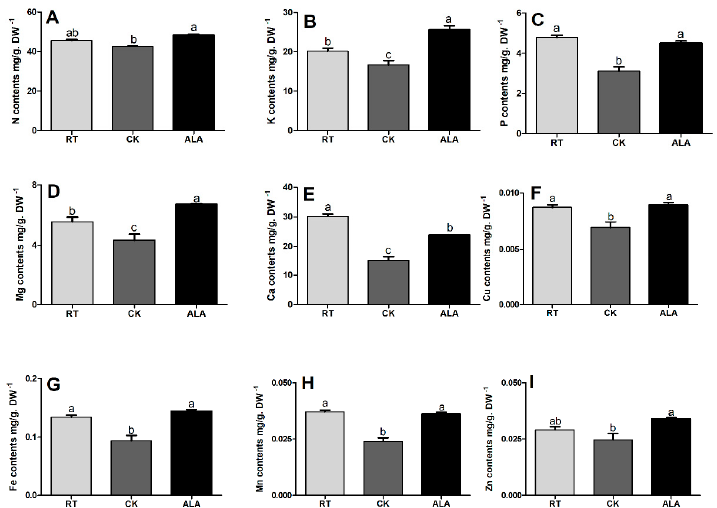
Figure 6. Effect of ALA on nutrient contents ( A ; Nitrogen, B ; Potassium, C ; Phosphorus, D ; Magnesium, E ; Calcium, F ; Copper, G ; Iron, H ; Manganese, and I ; Zinc) in cucumber seedling leaves under low-temperature stress. RT = regular temperature; CK = control; ALA = 30 mg/L ALA. Different letters indicate a significant difference at p < 0.05.